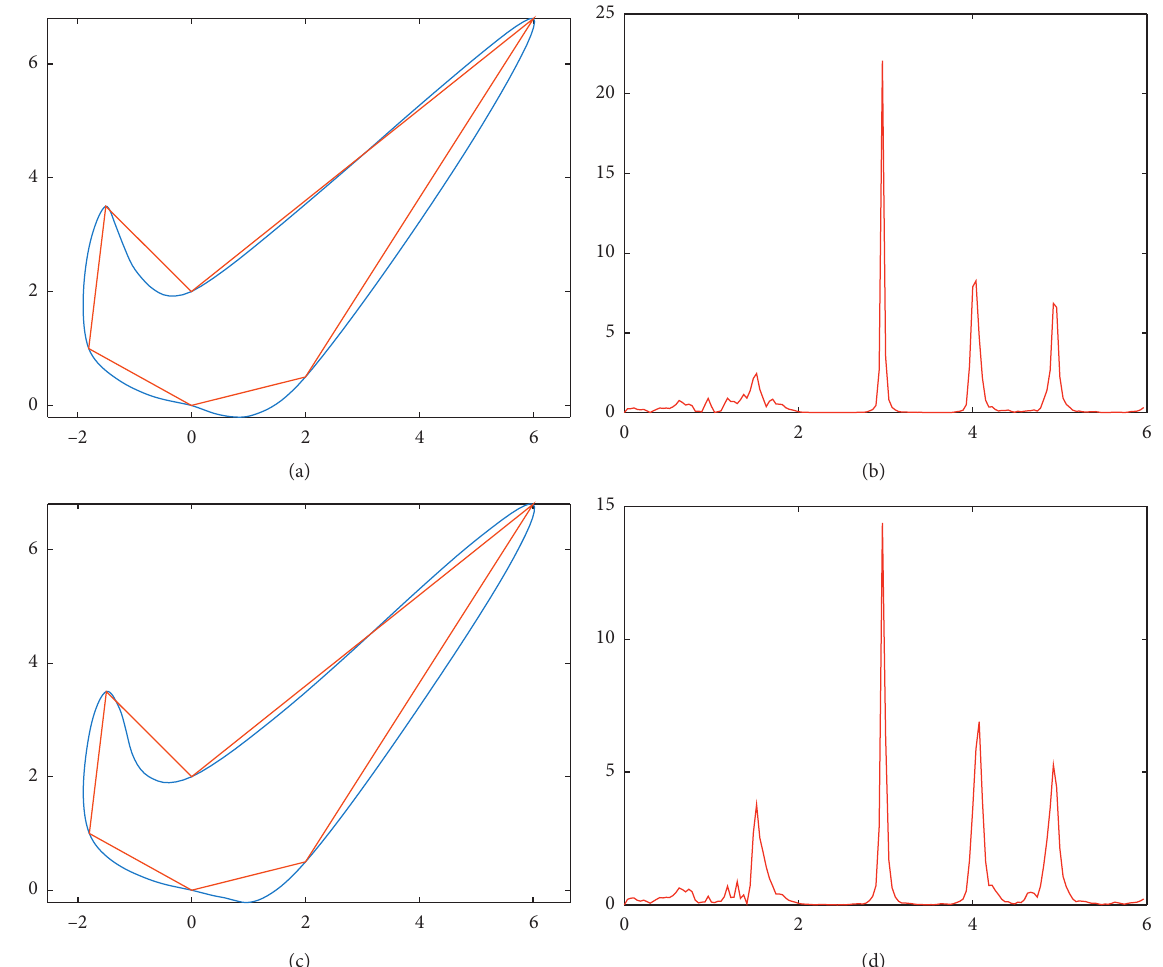
Figure 2: Limit curves and their curvature figures. (a) Stationary Nike by (1). (b) Curvature of stationary curvature (1). (c) nonstationary Nike by (2). (d) Curvature of stationary curvature (2).